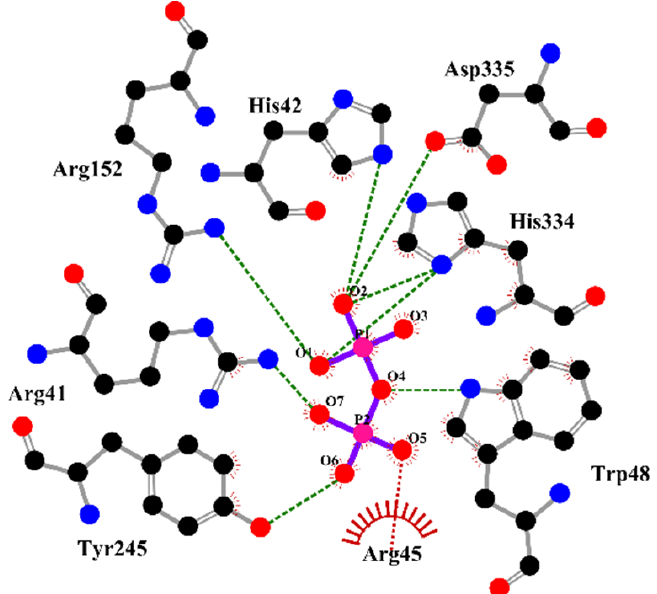
Figure 7. Schematic representation (2D) of residues in the substrate-binding site of Eh HAPp49 exhibiting interactions with inorganic pyrophosphate. Color codes: hydrogen bonds, green dashes; salt bridges, red dashes/arcs; carbon, black; oxygen, red; nitrogen, blue; phosphorous, pink; ligand bonds, purple; protein bonds,